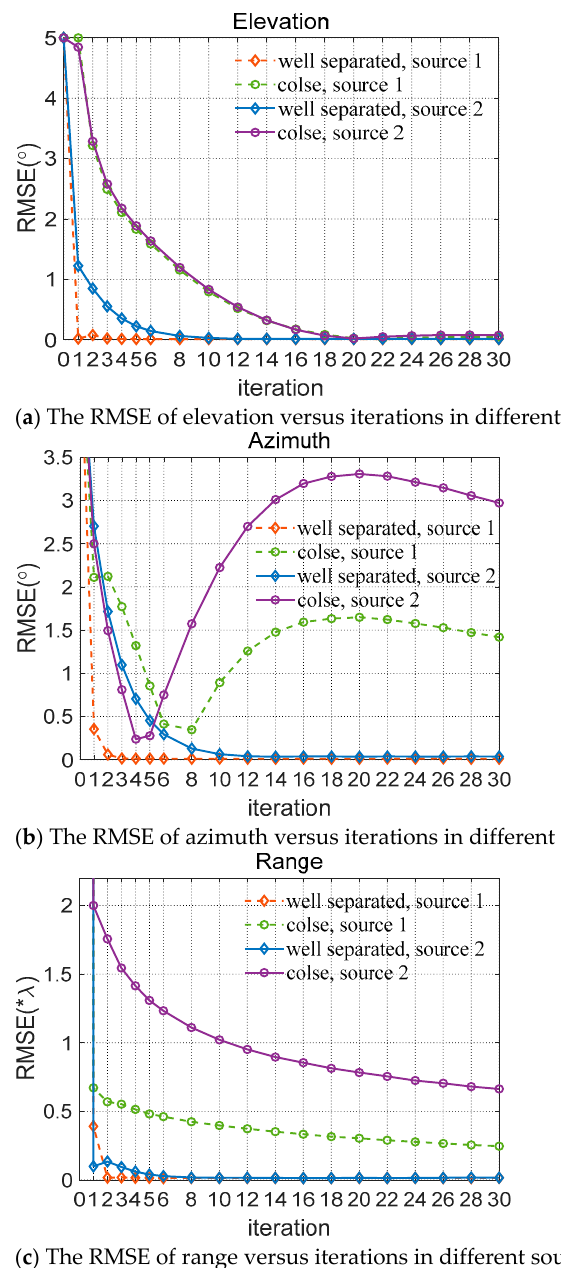
Figure 6. Convergence comparison of the source spacing. CASE